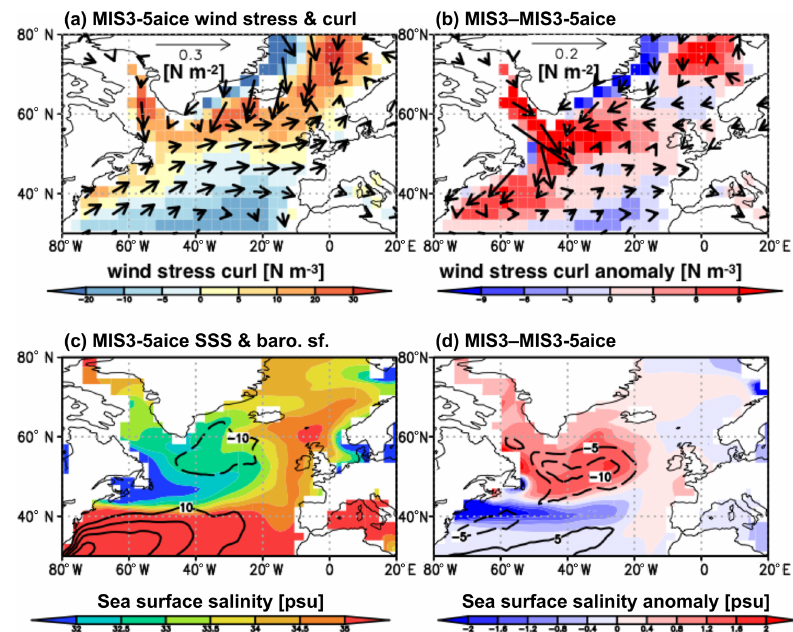
Figure 8. Changes in surface wind stress and wind-driven ocean circulation associated with expansion of the northern glacial ice sheet from MIS5a to MIS3. Panels (a) and (b) show the surface wind stress (arrow, Nm − 2 ) and wind stress curl (color, Nm − 3 ), and panels (c) and (d) show the barotropic streamfunction (contour, Sv) and sea surface salinity (color, psu). Panels (a) and (c) show MIS3-5aice, and panels (b) and (d) show MIS3 minus MIS3-5aice (ice sheet effect). The climatology of the last 100 years is used to create these figures.